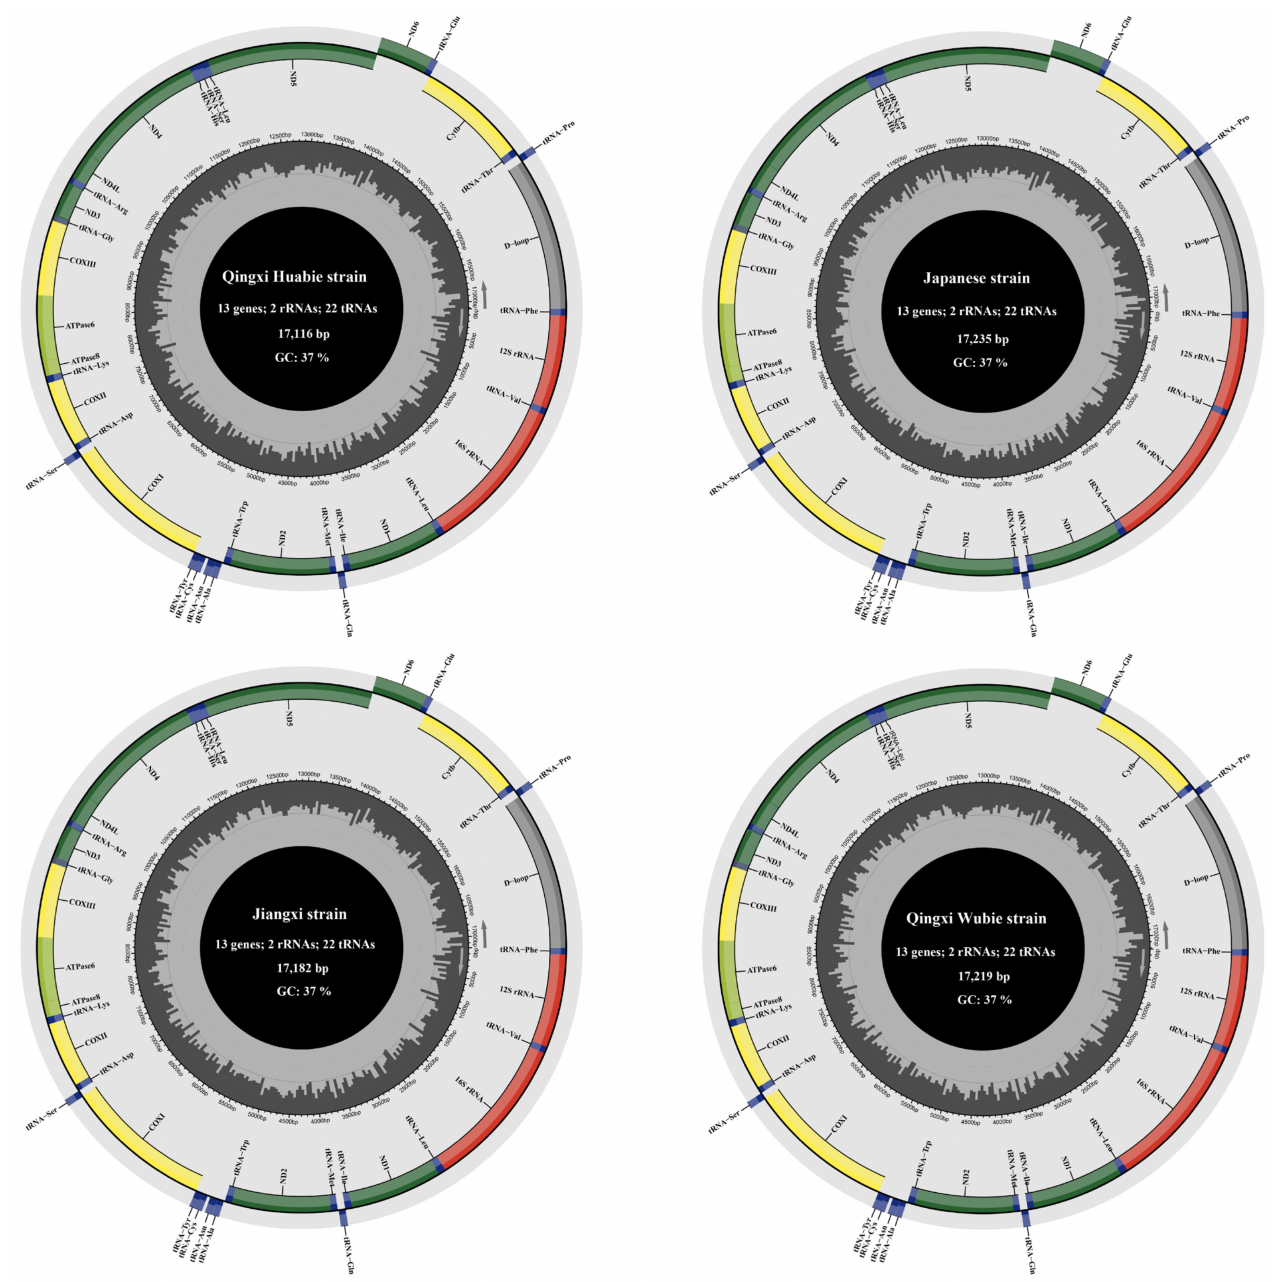
Figure 1. Mitochondrial genome maps of four P. sinensis strains . The outer circle represents the light chain (L-chain), and the inner circle represents the heavy chain (H-chain). The dark green box represents mitochondrial complex I (NADH dehydrogenase); the yellow box represents complex IV (cytochrome c oxidase); the light green circle represents ATP synthase; the blue circle represents transfer RNA; the red circle represents ribosomal RNA; and the grey circle represents the control region